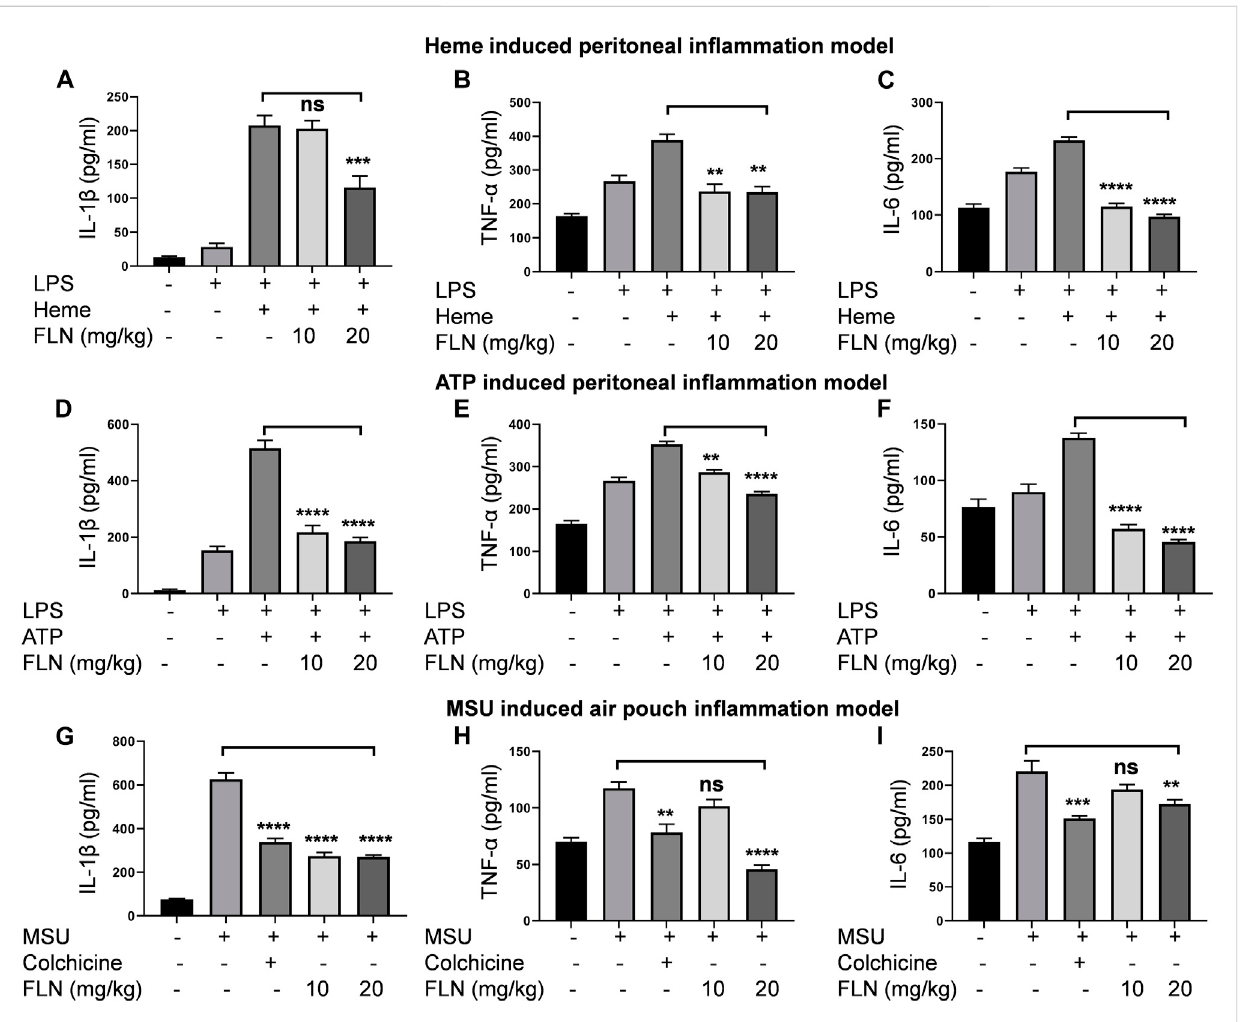
FLN inhibits proin fl ammatory cytokines production in different mice models. Levels of IL-1 β , TNF- α , and IL-6 were analyzed in peritoneal or air pouch lavages ofBALB/c micethroughELISA. BALB/c mice (n= 5)wereinjected withFLN10 mg/kg and 20 mg/kg orvehiclefor30 minintheperitoneal cavity. LPS, 2 mg/kg was injected as the primary signal for in fl ammasome activation for 4 h, followed by heme (5 μ M) for 1 h or ATP (100 mM) for 15 min. For MSU inducedair pouch in fl ammation model, differentdoses of FLN, 10 mg/kg and 20 mg/kg, colchicine(1 mg/kg) or vehicle wereinjected into theairpouch intheBALB/cmice (n=5) for 30 minfollowedbyMSU (3 mg/mL) injection for6 h. Thelevels of (A) IL-1 β , (B) TNF- α and (C) IL-6 secreted in response to heme induced NLRP3 in fl ammasome and (D) IL-1 β , (E) TNF- α and (F) IL-6 secreted in response to ATP induced NLRP3 in fl ammasome. The levels of (G) IL-1 β , (H) TNF- α and (I) IL-6 secreted in MSU-derived air pouch in fl ammation in mice. Colchicine was used as a standard inhibitor in the air pouch model of in fl ammation. Data represent the mean of cytokines released by different mice in a group ±SD. Statistical signi fi cance was measured